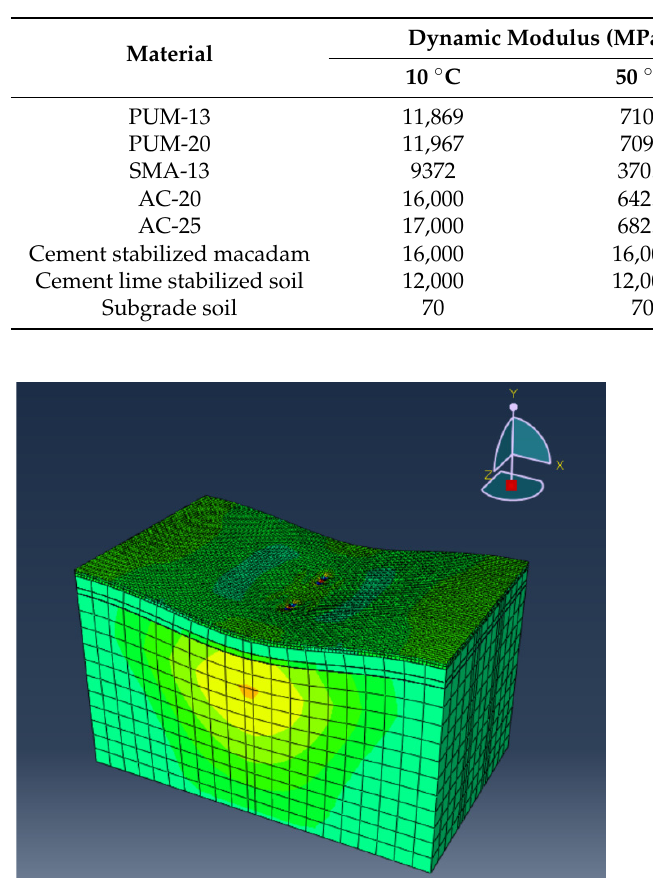
Figure 5. Calculation model for the road structure. Table 4. Material parameters of each structural layer.